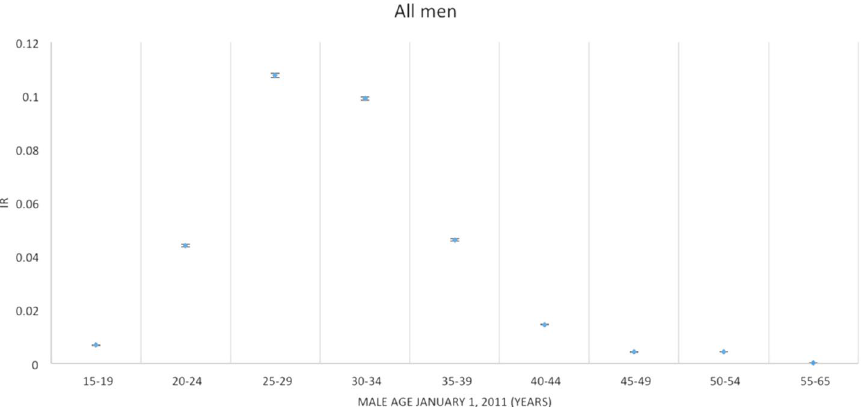
Figure 1. Incidence rates (IR) of fathering a child according to age 1 in each age group for the entire study period. Men aged 15–65 years living in Denmark January 1, 2011 to December 31, 2015. 1 Age according to the man’s age by January 1, 2011 divided into age groups.